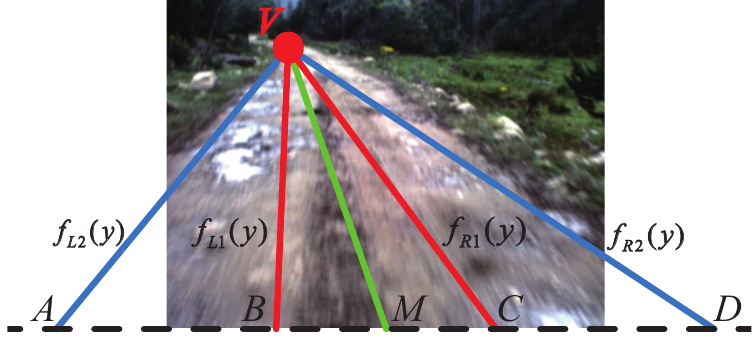
Figure 15. Image division for probability map calculation.